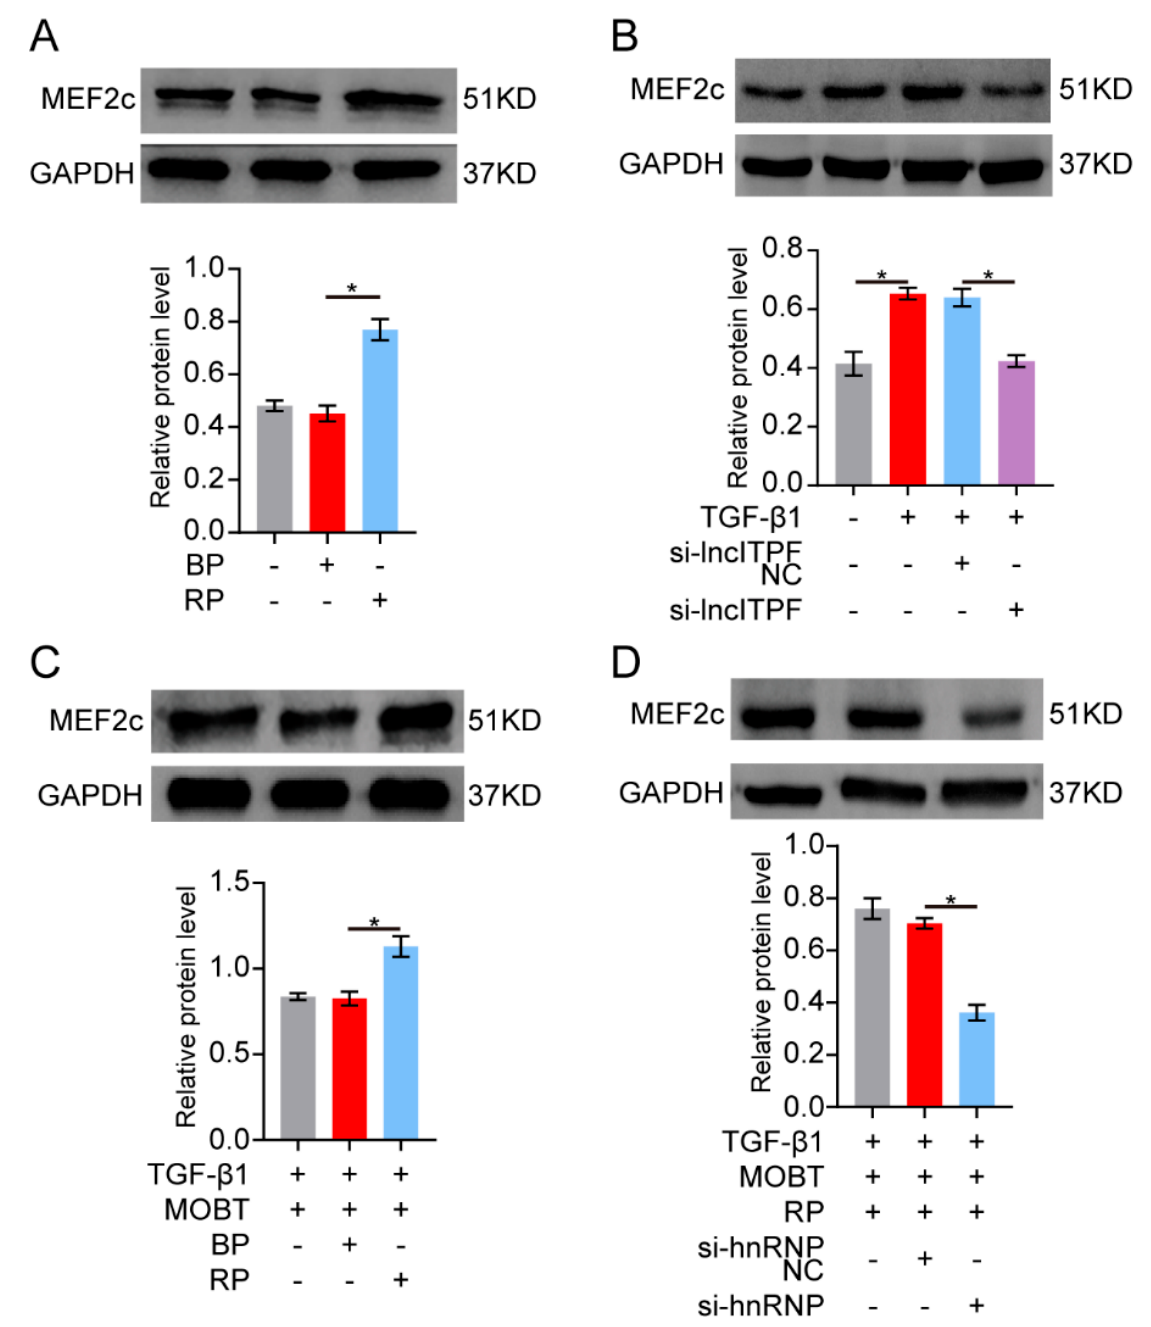
Figure 5. MOBT downregulated MEF2c expression through the lncITPF–hnRNP L complex. ( A ) The Western blot analysis showed that lncITPF overexpression promoted the expression level of MEF2c. ( B ) The Western blot analysis showed that si-lncITPF reduced the expression level of MEF2c. ( C ) The rescue experiments discovered that overexpression of lncITPF reversed the MOBT function, resulting in the blockage of MEF2c expression. ( D ) The rescue experiments demonstrated that si-hnRNP L reversed the joint action of MOBT and overexpression of lncITPF, resulting in a repressed MEF2c level. NC meant the negative control, BP meant the blank plasmid, and RP meant the overexpressed lncITPF recombinant plasmid. Each bar represents mean ± SD, * p < 0.05.